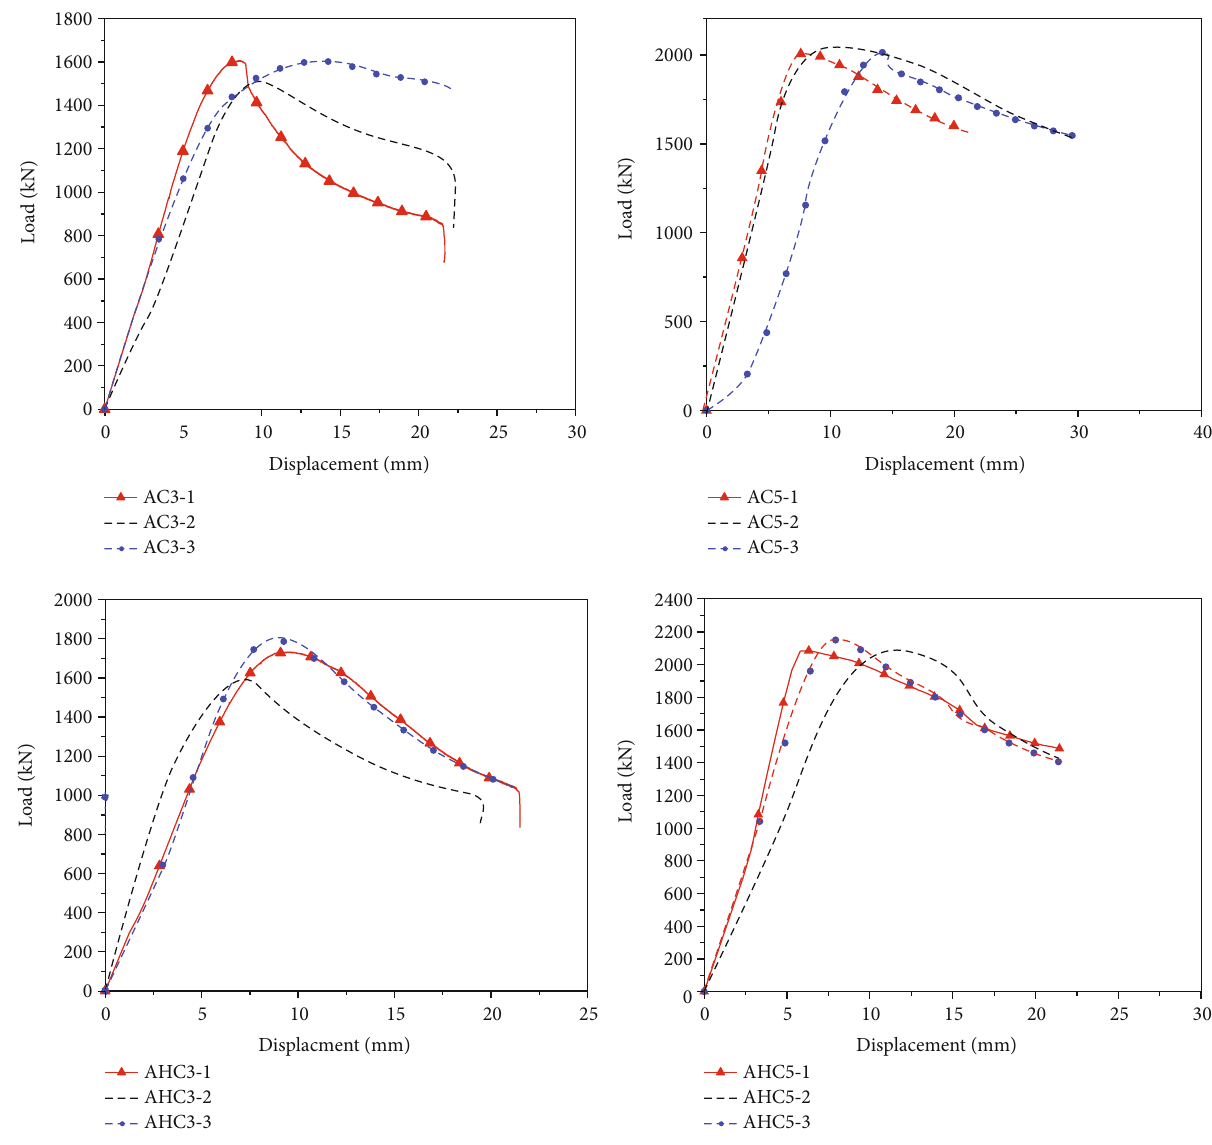
Figure 5: Test load-displacement curve.